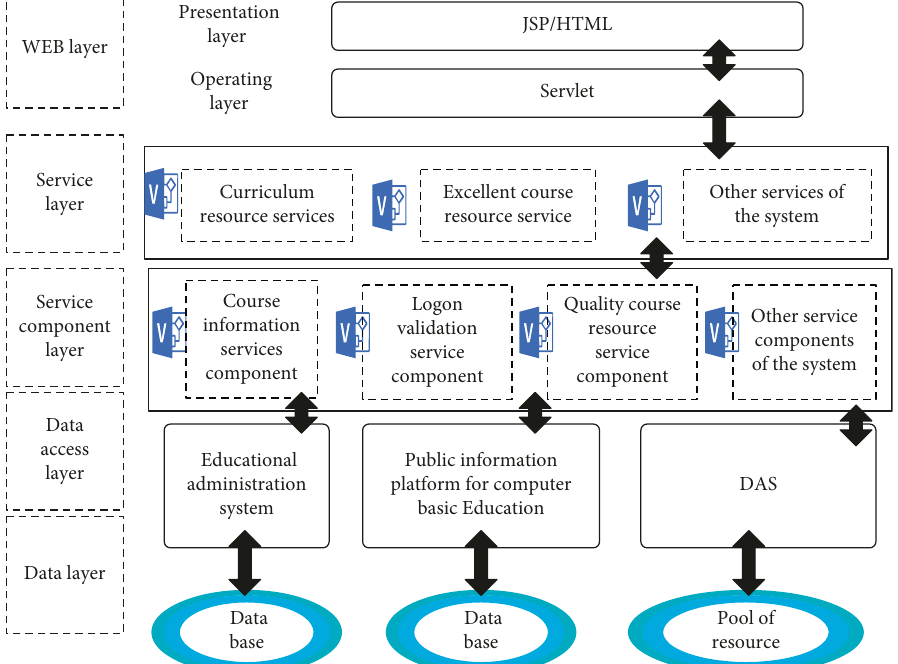
Figure 7: Structure diagram of the system